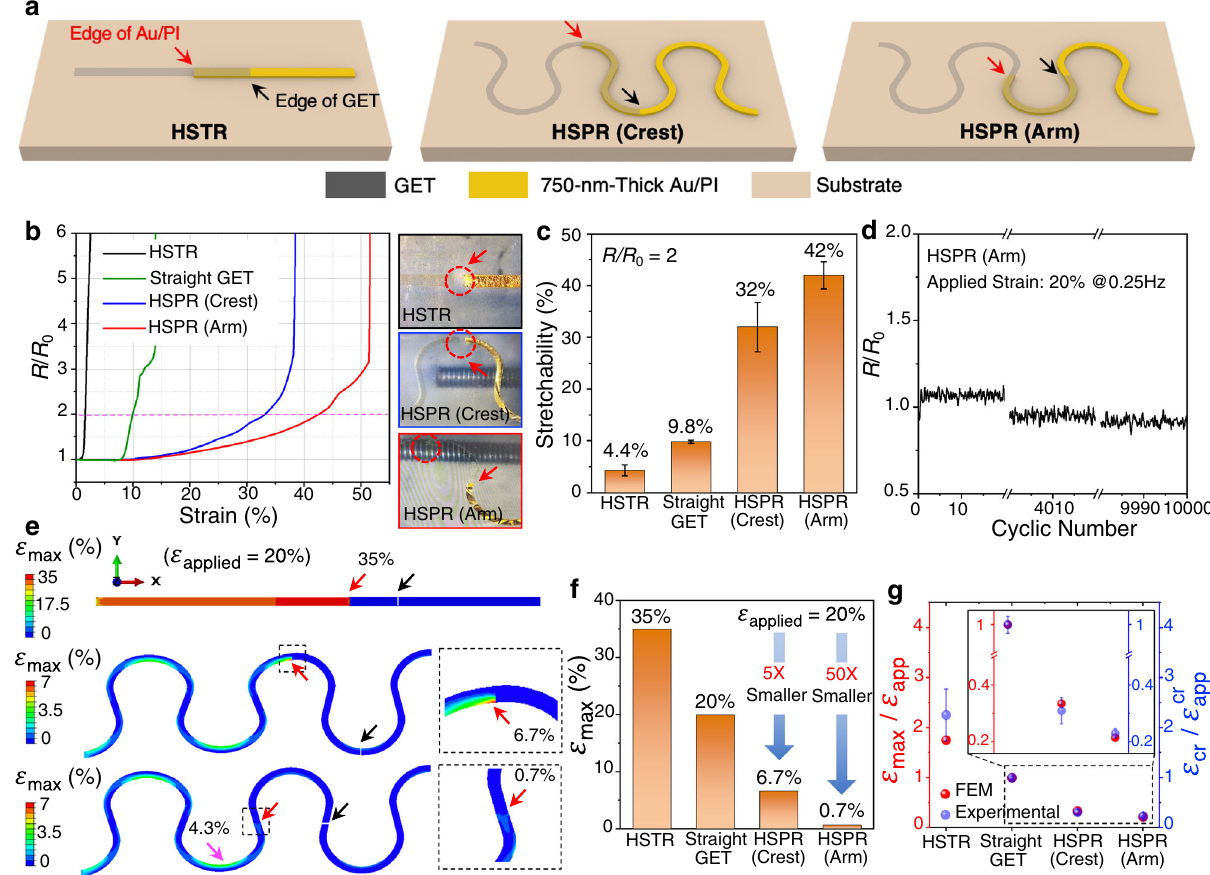
Fig. 2 | Mechanical characterization and modeling of HSPR. a Three different heterogeneous con fi gurations (HSTR, HSPR (Crest), HSPR (Arm)) supported by 100- µ m-thickEco fl exsubstratesarestretchedexperimentallyandnumerically.The red arrow and black arrow highlight the edge of Au/PI and the edge of GET, respectively. b The resistance change vs. strain for the three different con fi gura- tions in comparison with a homogenous straight GET. Micrographs at fracture are displayed on the right. Red-dashed circles indicate the fractured sites. c Stretchabilityextractedat R / R 0 =2isplottedinabarchartfordirectcomparison. Errorbarsrepresentthestandarddeviationofthreeindependenttests. d Cyclictest